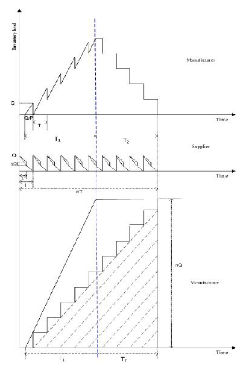
Fig. 1. Total inventory profile for the manufacturer and the